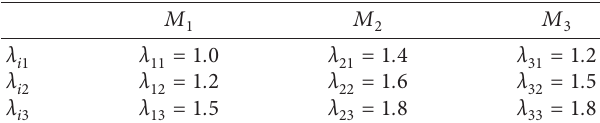
Table 2: Failure rate of virtual machine M